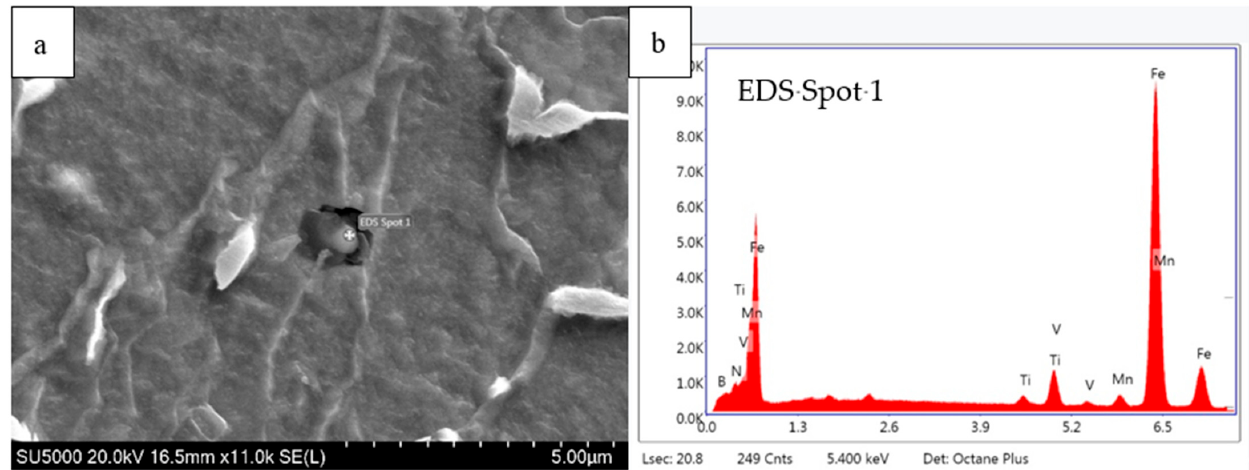
Figure 11. Typical SEM micrograph of IGAF nucleating possibly at a (Ti,V)(C,N) particle ( a ) and EDS analysis of the corresponding particle ( b ).